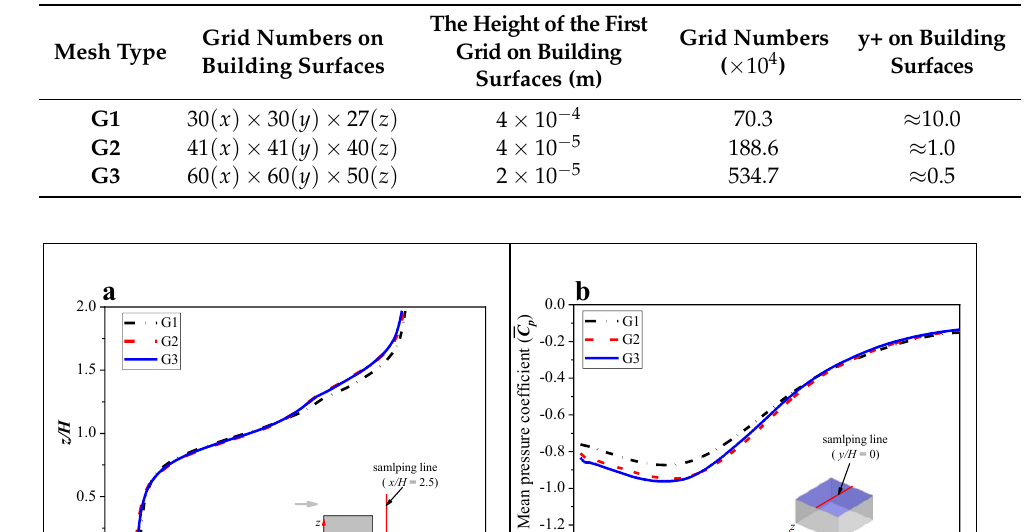
Table 2. Mesh detail parameters for G1, G2, and G3.